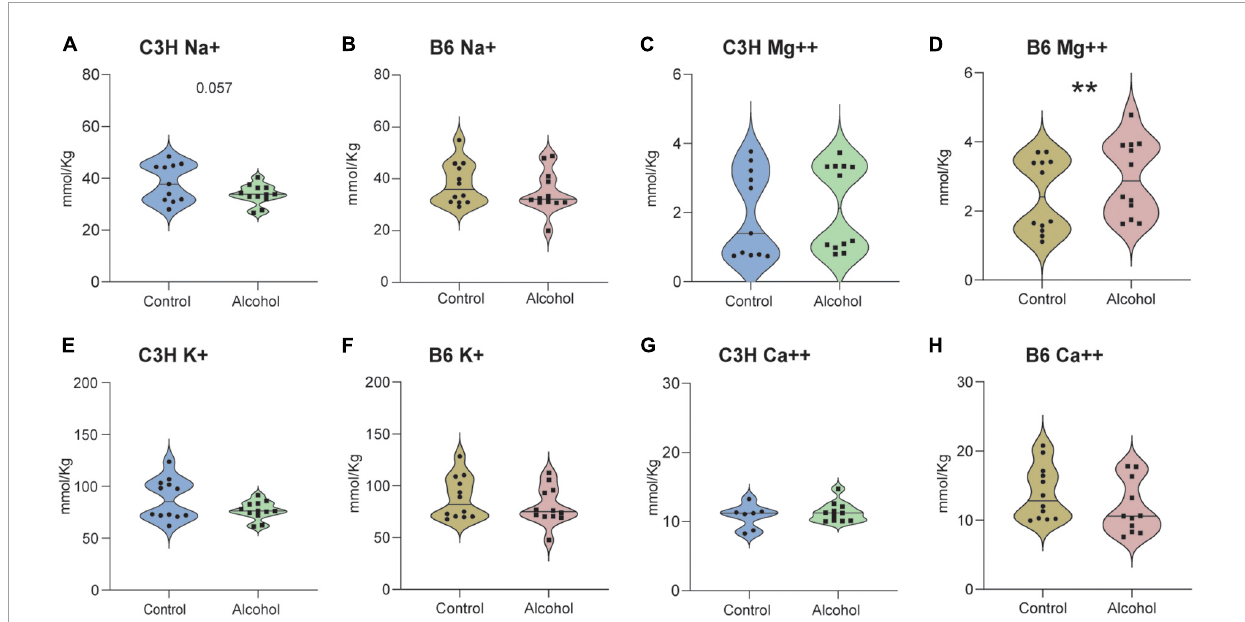
FIGURE12 Cation alterations following alcohol exposure in the cerebellum of C3H and B6 mice. The concentration of cations Na + (A,B) , Mg ++ (C,D) , K + (E,F) , Ca ++ (G,H) in the cerebellum of C3H and B6 mice. Data are shown as individual subjects with violin plots. n = 8–12 per group/strain. ** p < 0.01